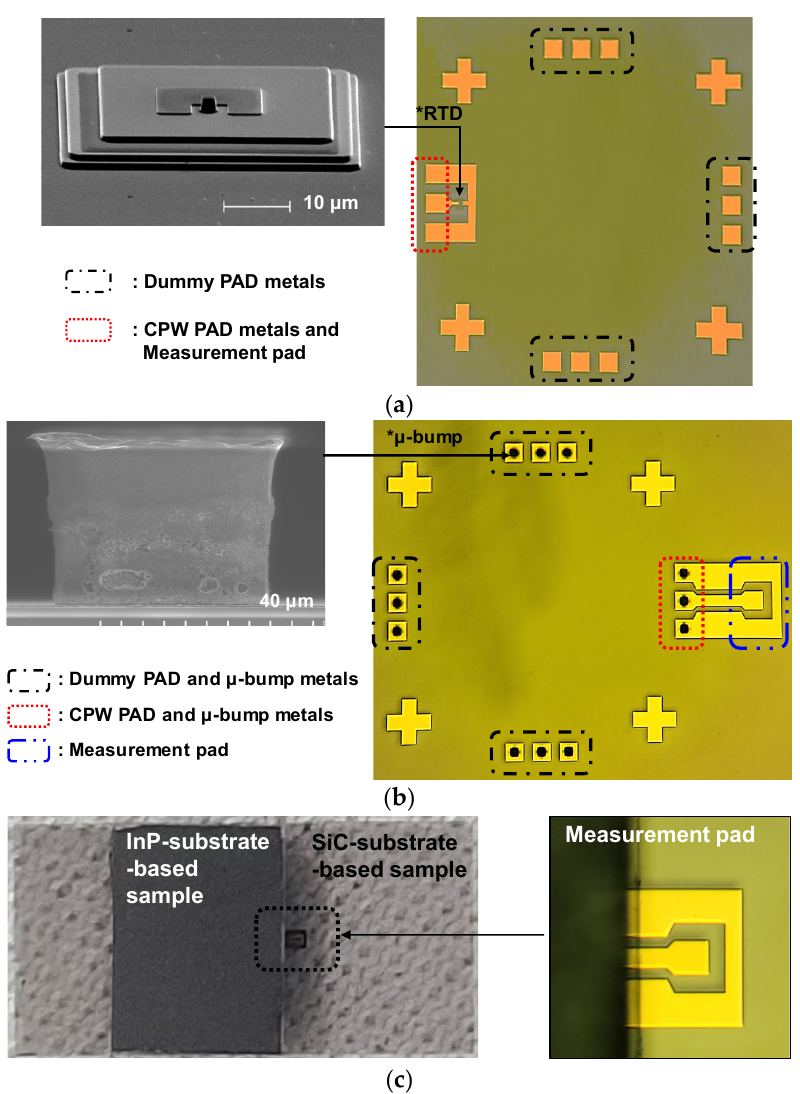
Figure 12. Implementation results of a flip-chip bonded InP-to-SiC resonant tunneling diode (RTD): ( a ) an InP-substrate-based sample; ( b ) a SiC-substrate-based sample; ( c ) a flip-chip-bonded sample with an InP-to-SiC RTD.